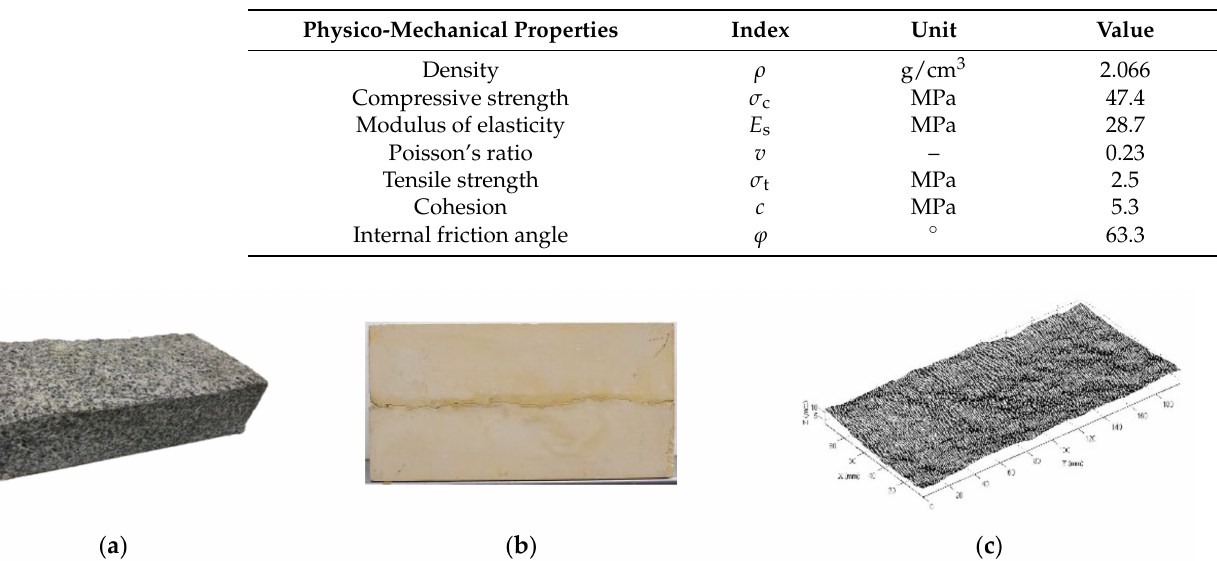
Figure 1. The production process of gypsum joint specimen and rough surface morphology of joint. ( a ) Granite joint obtained from artificial splitting. ( b ) Cast plaster structure interview piece. ( c ) scanning graphs of the fracture